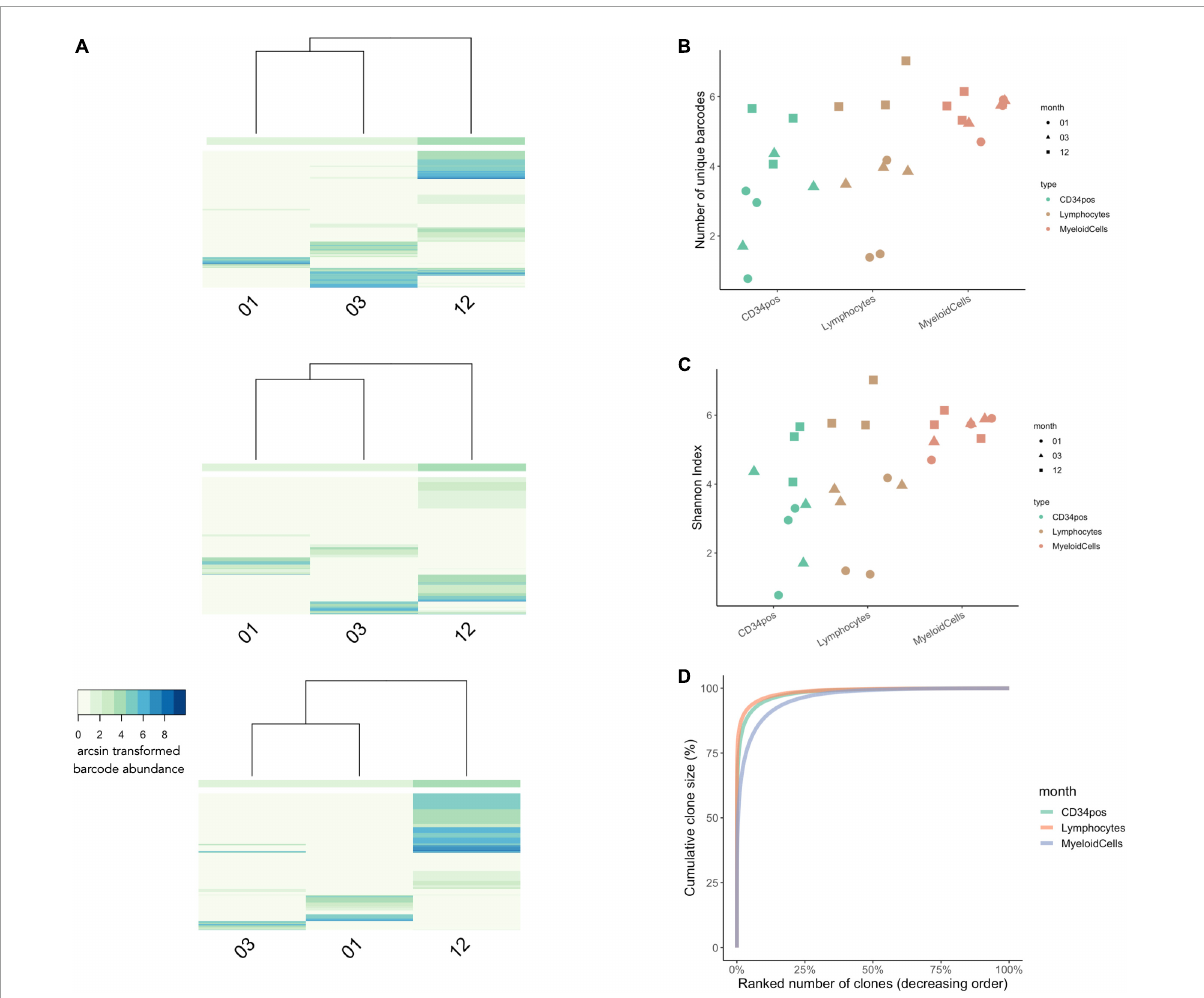
FIGURE7 Clonal Diversity in WAS Patients Undergoing Gene-Therapy from 1 to 12 months post-transplantation. (A) Unsupervised hierarchical clustering and heatmap visualization of barcode abundances across timepoints for each patient. The x-axis shows the timepoint post-transplantation. The y-axis corresponds to each unique IS (patient 1 had a total of 4,397 unique integration sites, patient 2 had a total of 5,317 integration sites, and patient 3 had a total of 6093 integration sites). The colors indicate the arcsin transformed read abundance. Hierarchical clustering was performed using the Euclidian distance and complete linkage. (B) The number of unique IS per cell lineage at 1, 3, and 12 months post-transplantation (in green, red, and blue, respectively). (C) Comparisons of Shannon Index measures across cell types and timepoints. (D) Cumulative clone size diagram shows that 25% of clones made up to 99% of the total IS abundances for all three time points [same colors as in panel (B) ]. N = 3 patients in all